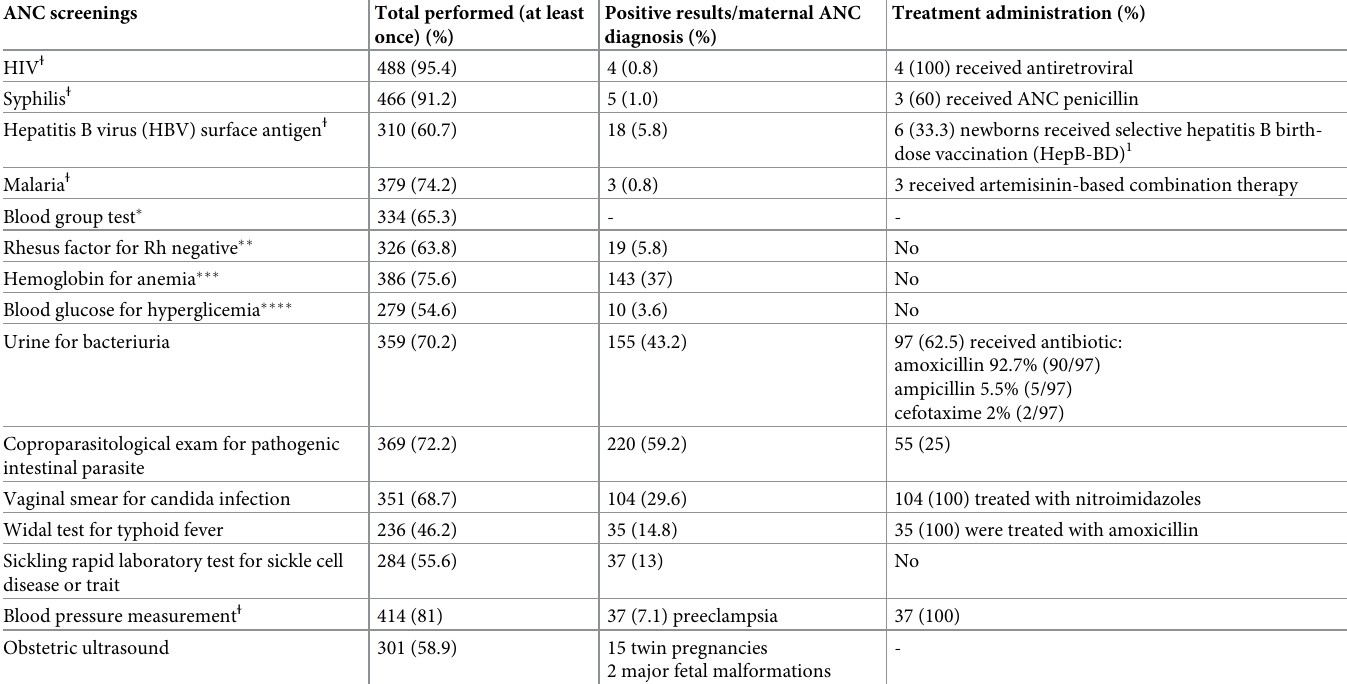
Table 2. Total screenings performed, maternal ANC diagnosis and treatments prescribed for study participants